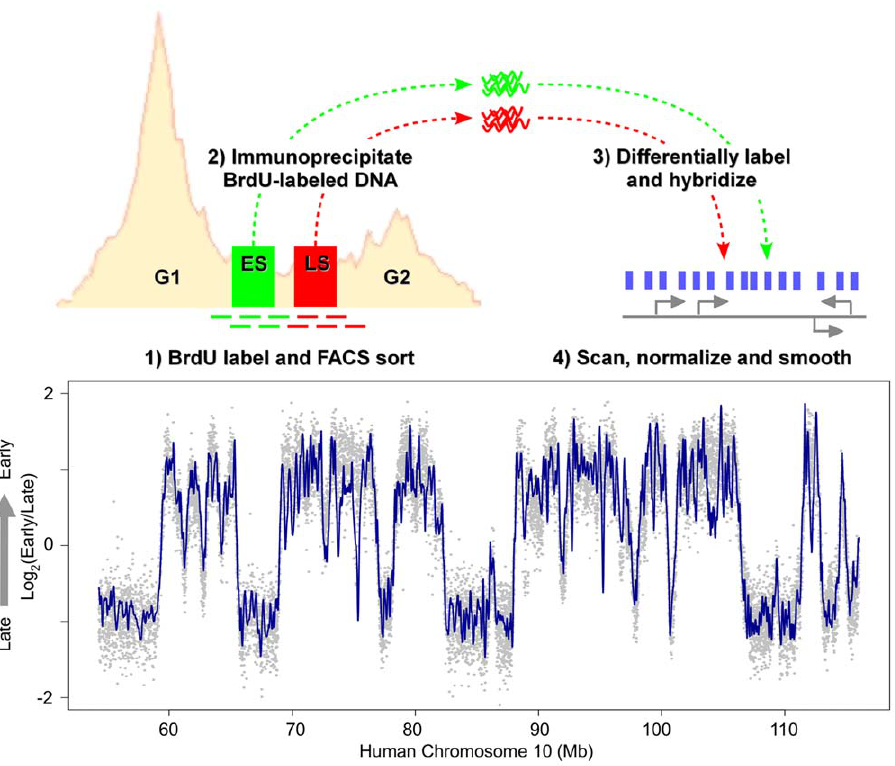
Figure 1. Method for generation of genome-wide replication profiles of primary myoblasts. Step 1 illustrates BrdU labeling of actively dividing cells for 2 hours, followed by fixation and FACS sorting by DNA content into early and late S phase fractions. In step 2, BrdU-labeled DNA from each fraction was isolated by immunoprecipitation. Step 3 involved differential-labeling and co-hybridization to a whole-genome human CGH microarray. For the final step, arrays were scanned and the extracted log 2 (early/late) raw data was Loess normalized (represented by gray data points) and then smoothed (dark blue curve) [35]. Shown is a profile of approximately 60 Mb of chromosome 10 for patient CM1.